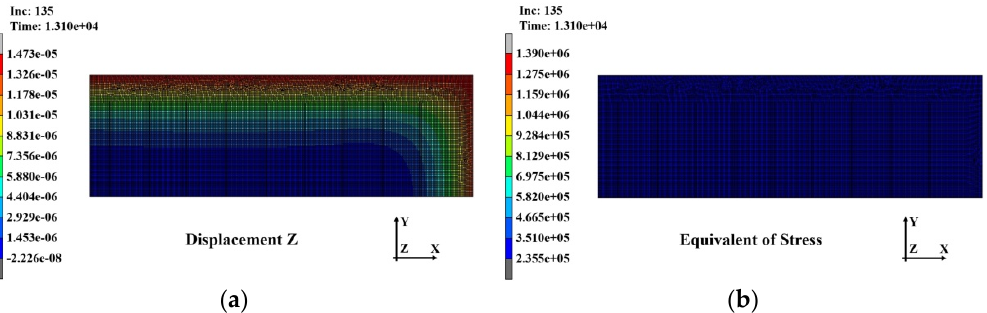
Figure 17. Analysis results of the substrate after first . laminating: ( a ) warpage distribution (14.73 μ m); ( b ) stress distribution (1.39 MPa).